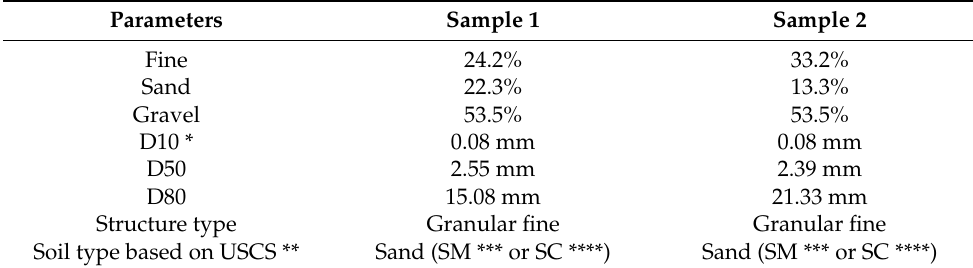
Table 2. Soil characteristics of the two samples [3].